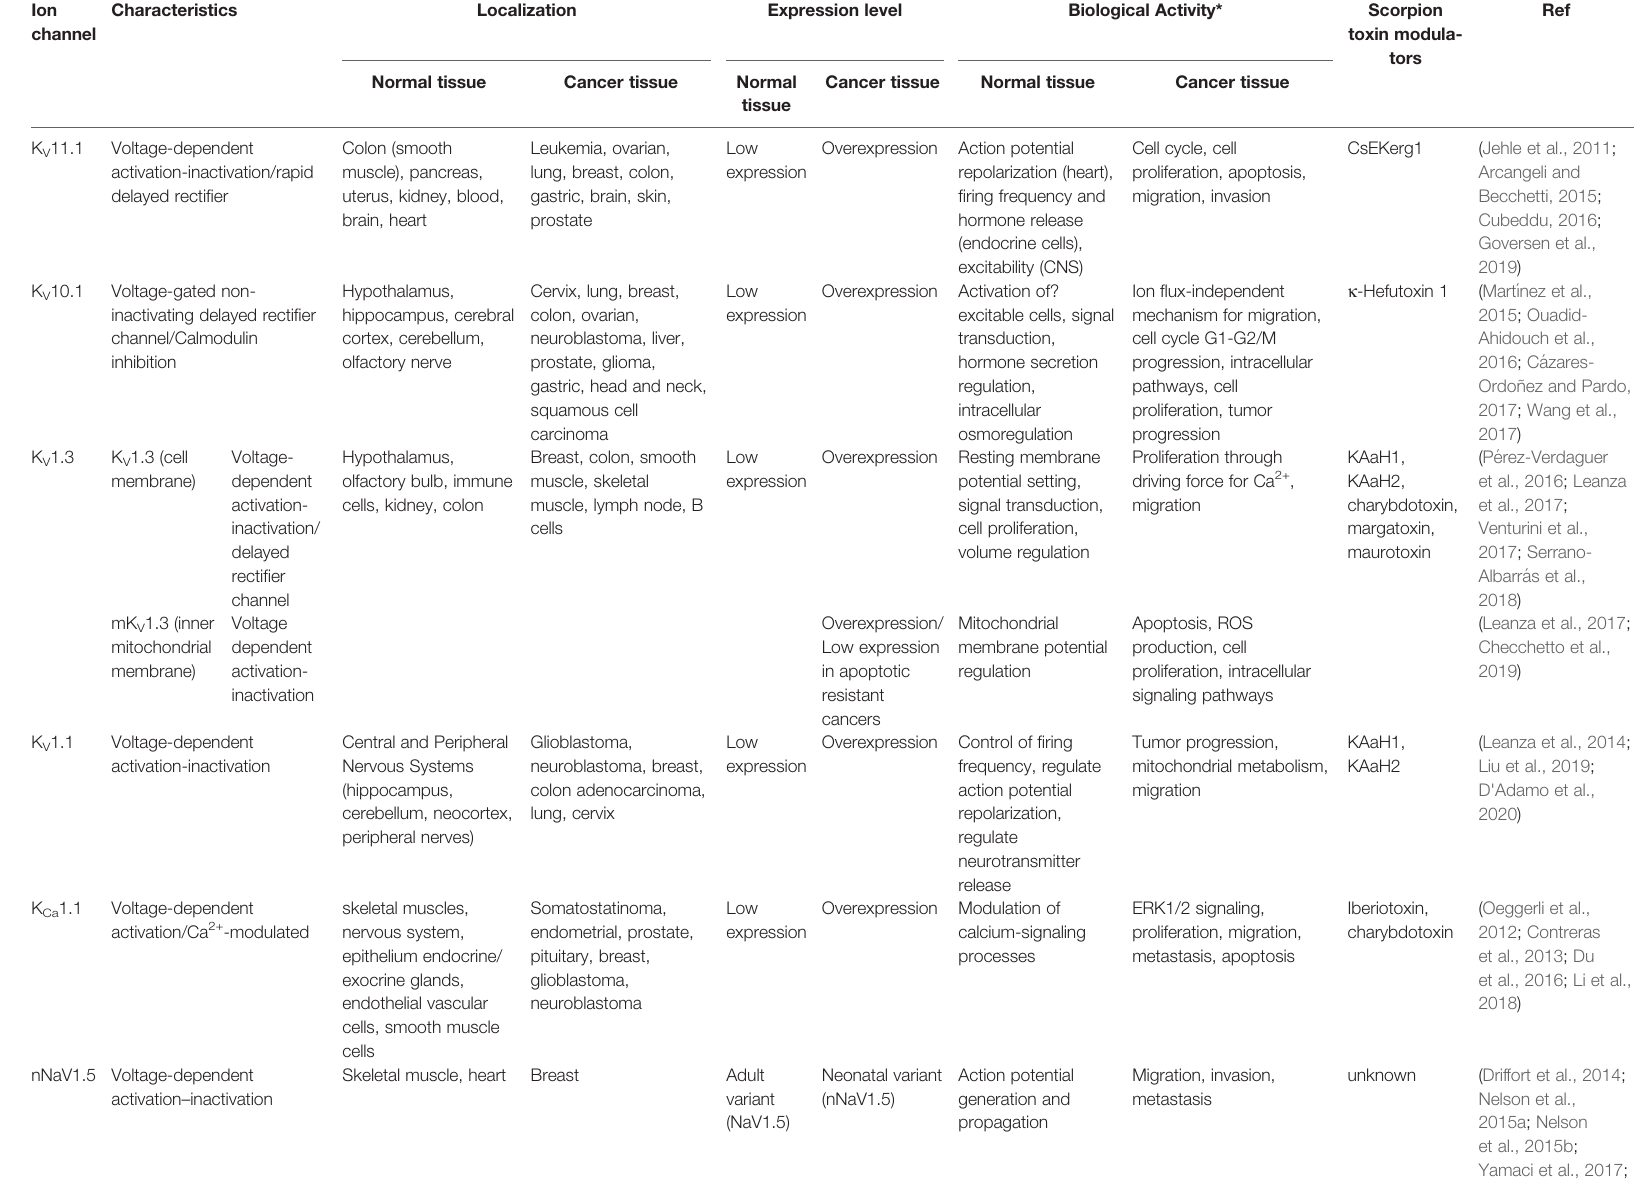
TABLE 1 | Main characteristics of the most studied cancer-related K + /Na + -channels and their recognized modulating